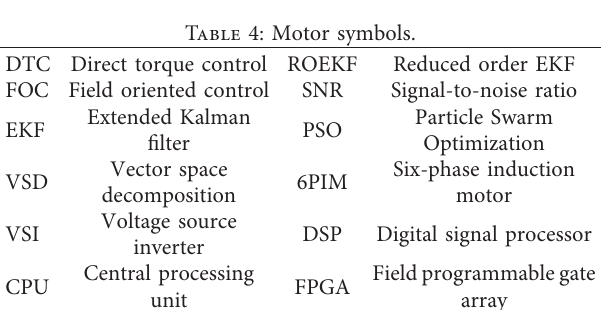
Table 4: Motor symbols.